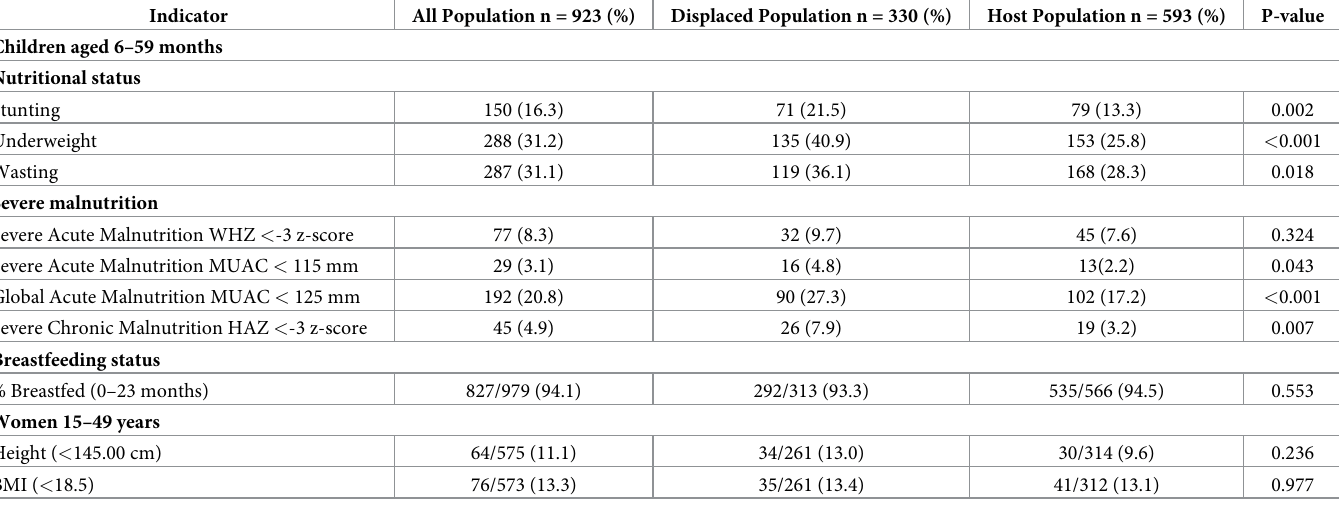
Table 3. Nutritional status of the children, 6–59 months old, presented with diarrhea episodes to DTCs � , April-December 2018, Cox’s Bazar, Bangladesh.